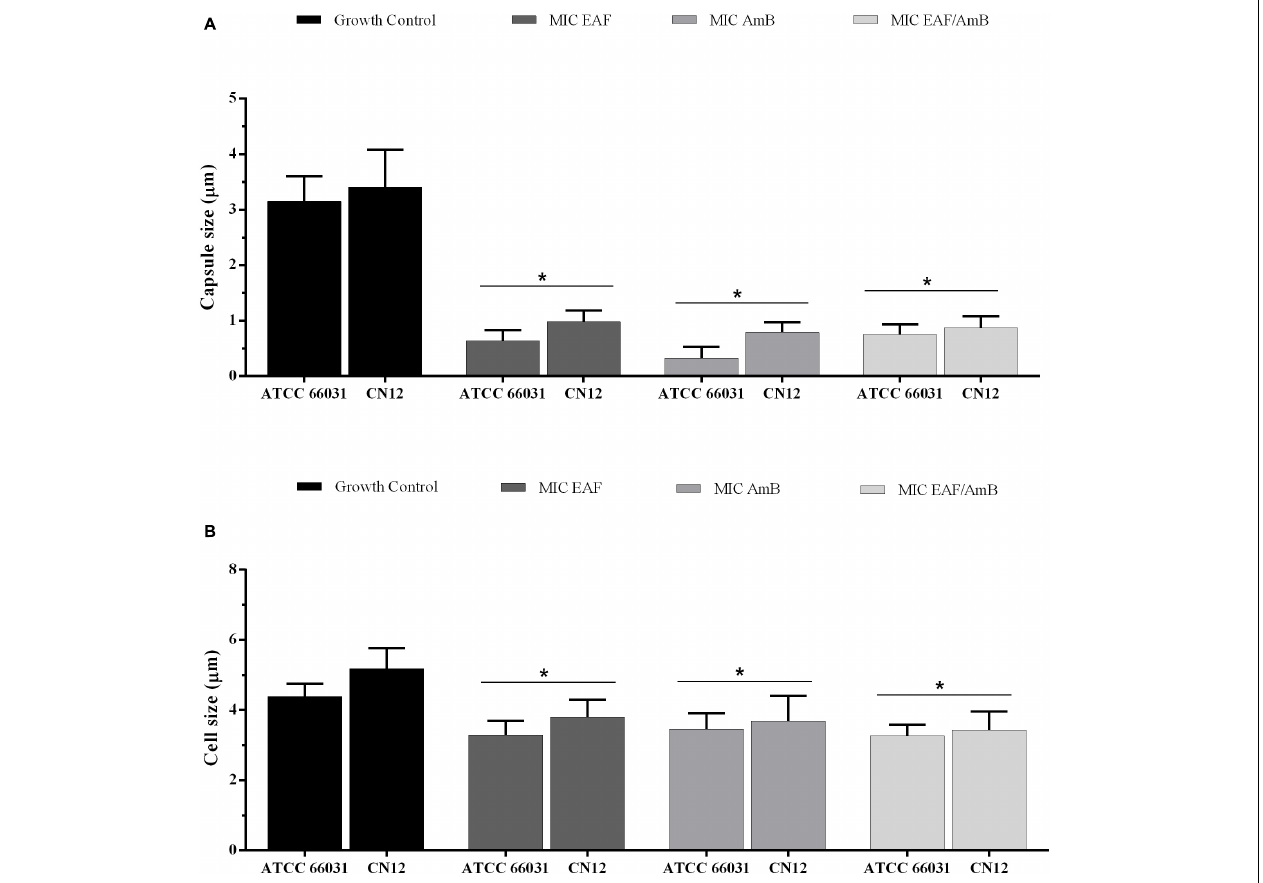
FIGURE 3 | Effect of ethyl acetate fraction (EAF) of Poincianella pluviosa bark and amphotericin B (AmB) alone or in combination on capsule (A) and cell (B) size. Cryptococcus neoformans ATCC 66031 and C. neoformans CN12 were treated with EAF minimal inhibitory concentration (MIC) (1,000.0 and 125 µ g/ml, respectively), AmB MIC (0.125 µ g/ml), and EAF combined with AmB (3.9/0.003 µ g/ml), and the results were compared to untreated control. A total of 100 cells were measured, and the mean ± standard deviation was calculated and analyzed by one-way ANOVA. Asterisks indicate a significant reduction ( p < 0.05) in the metabolic activity of treated sessile cells compared to untreated